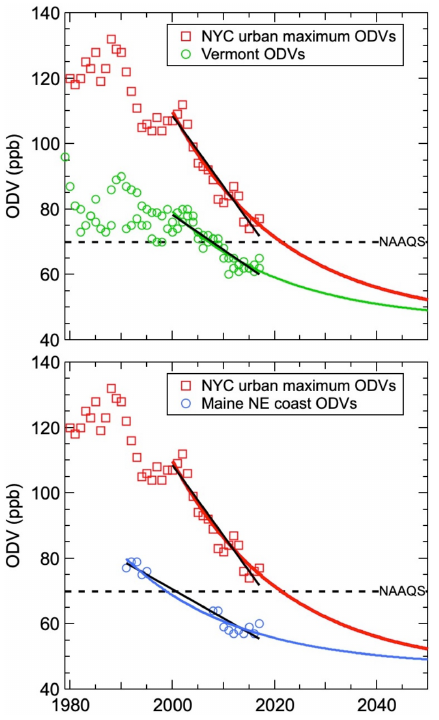
Figure 13. Comparison of linear and exponential fits to three ODV data sets. The black line segments are linear fits to 2000–2017 for two data sets and 1991–2017 for one data set. The colored curves are the exponential fits to these time series, also shown in Figs. 11, S9, and